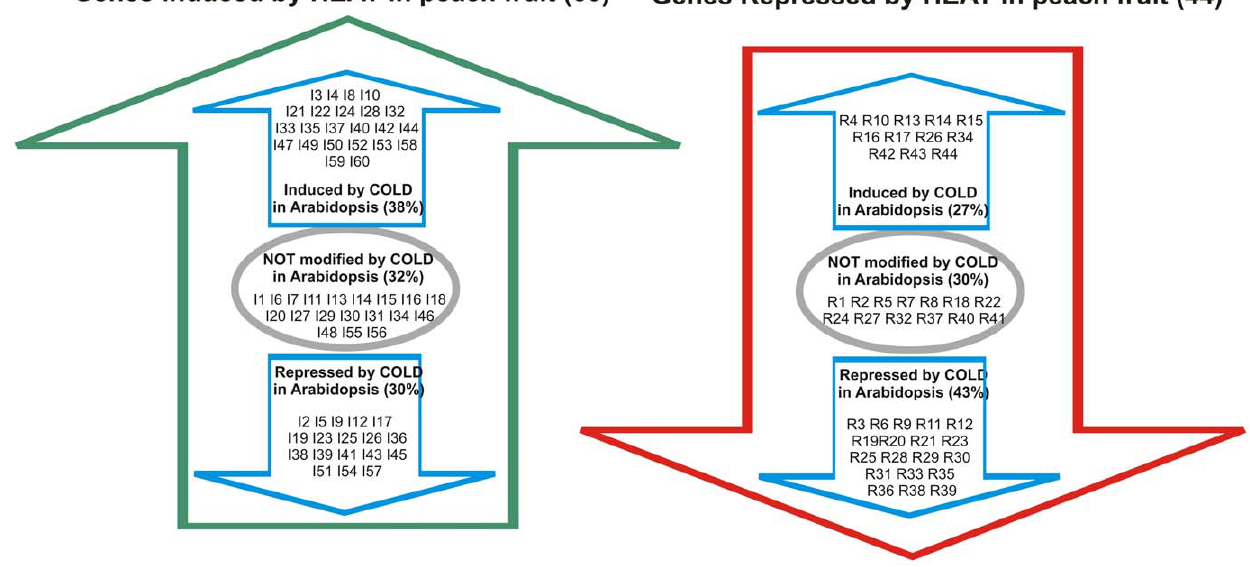
Figure 6. Classification of peach-heat-differentially expressed unigenes regarding their response to cold in Arabidopsis . Arabidopsis orthologs to the heat induced and repressed peach genes (Tables 2 and 3, respectively) were analyzed regarding their response to cold in Arabidopsis using the ColdArrayDB (http://cold.stanford.edu/cgi-bin/data.cgi). Within the induced and repressed peach genes, Arabidopsis orthologs with a fold- change higher than 1.5 in response to cold [33] are classified as induced or repressed, respectively. Genes with an absolute fold-change less than 1.5 are indicated as not modified by cold.